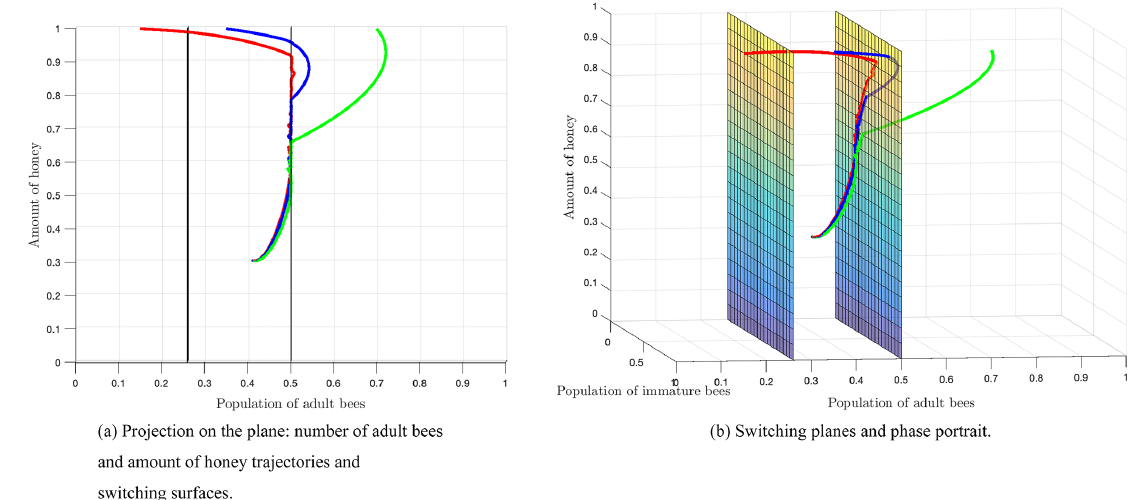
Figure 8. Numerical simulation of the model (Eq. 9) with initial conditions – number of immature bees: 1; number of adult bees: 0.15, 0.35 and 0.7; and amount of honey: 1. The trajectories are represented by the red, blue and green curves, respectively. The parameter values are given in Table